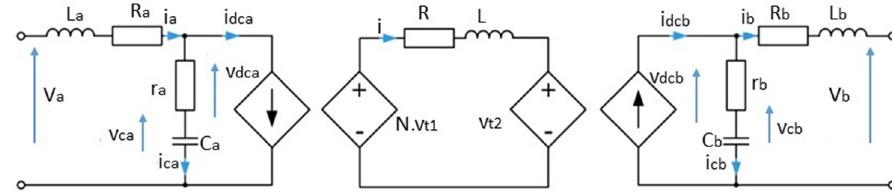
Figure 7. Average model of DAB–DC/DC converter.